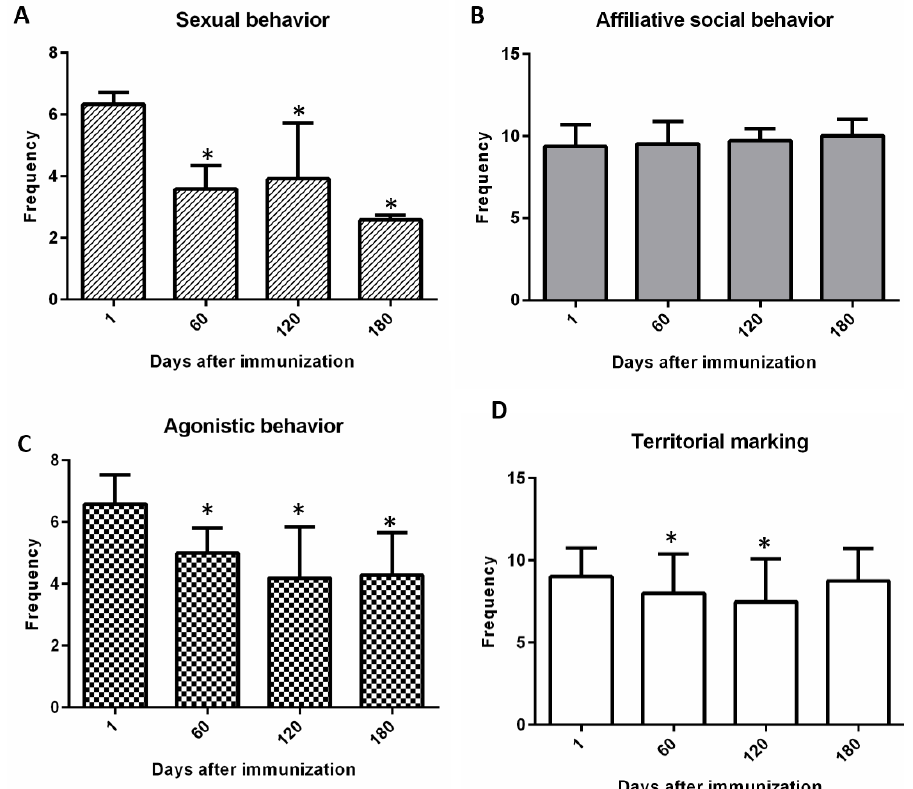
Figure 5. Vaccination changed the behavior of the vaccinated animals. Through surveys administered to owners on day 1, 60, 120, and 180 of the study, four behavioral categories were evaluated in the vaccinated dogs. Vaccination induced a decrease in sexual behaviors at days 60, 120, and 180 ( A ) but did not induce changes in affiliative behavior ( B ). Agonistic social behavior decreased during the entire study due to the vaccination ( C ) and territorial marking behavior decrease up to day 120 of the study ( D ). Asterisks (*) indicate significant differences in relation to day 0 ( p < 0.05).